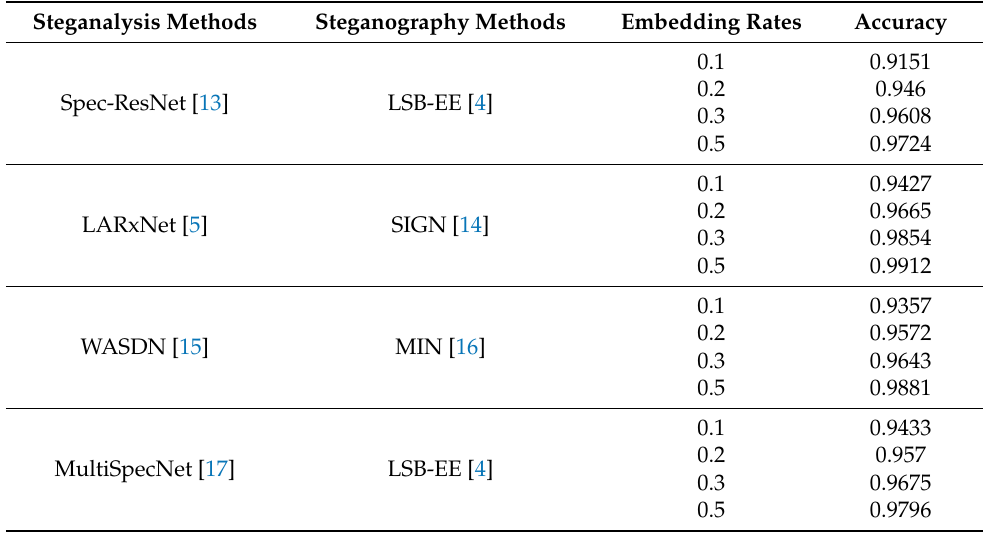
Table 1. The detection accuracy of different steganalysis methods based on deep learning under the different embedding